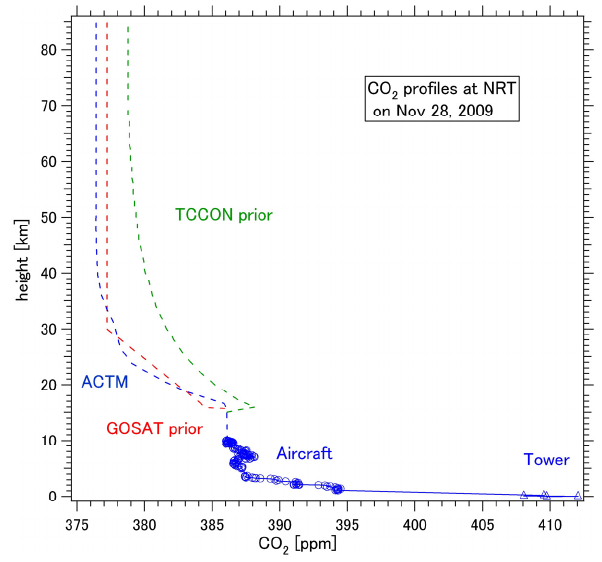
Fig. 5. Vertical profiles of CO 2 over Narita on 28 November 2009. Blue, red, and green dashed lines above the tropopause indicate profiles by ACTM, a priori as in the GOSAT retrieval, and a priori of TCCON, respectively. The blue solid lines show observation data, including aircraft measurements.